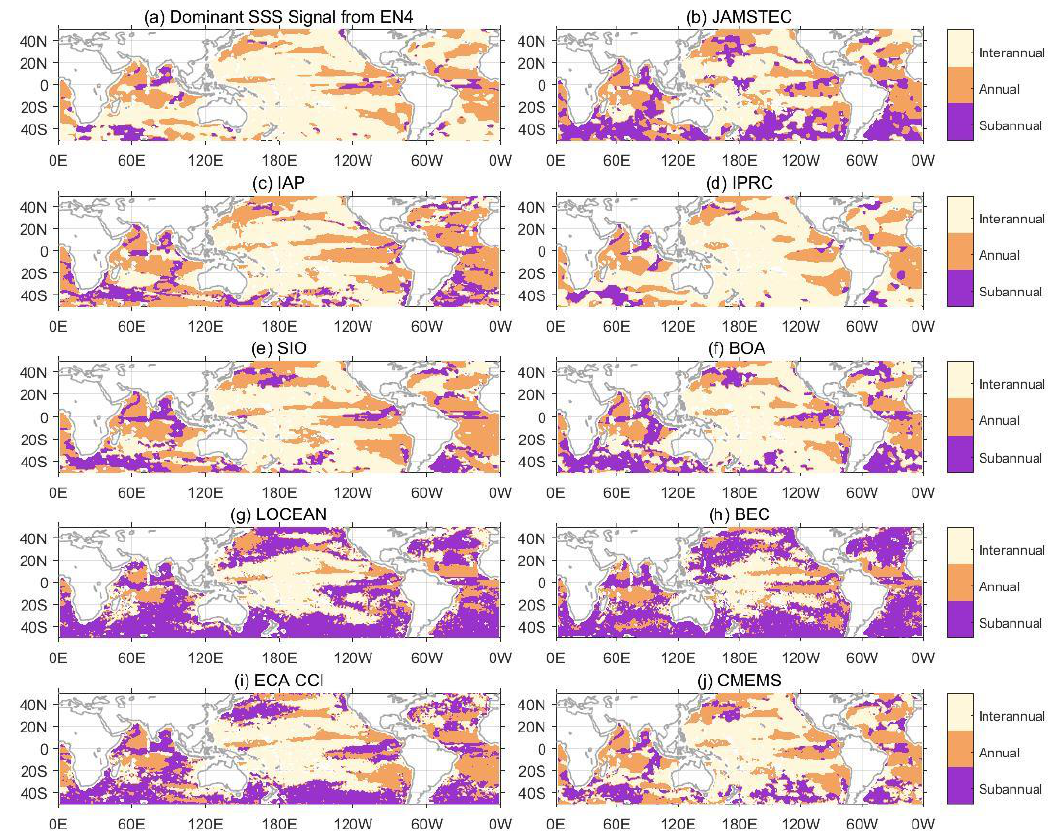
Figure 14. Horizontal distribution of the leading SSS mode over the global ocean.